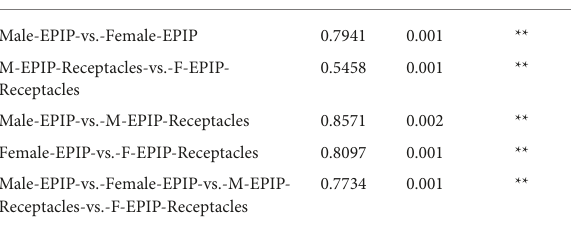
TABLE 2 Results of the between-group difference test at the operational taxonomic unit (OTU) level [analysis of similarities (ANOSIM) test based on unweighted